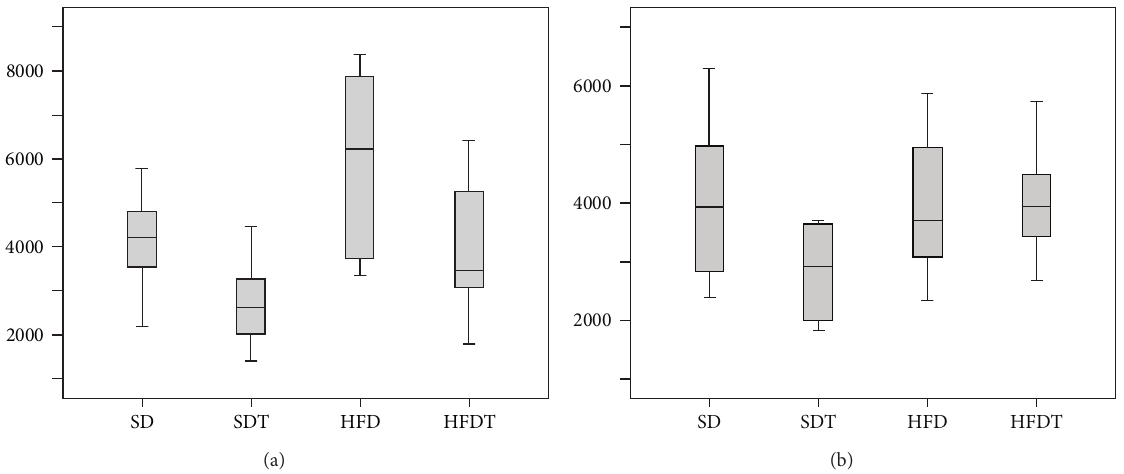
Figure 5: Semiquantitative analysis of the interaction between PTPIP51 and its interaction with IR and with PKA. Every section was subdivided into rectangles of the same size and dots were counted. The results were averaged for each section. (a) Semiquantitative evaluation of PTPIP51 interaction with IR. (b) Semiquantitative evaluation of PTPIP51 interaction with PKA. SD: standard diet group. SDT: standard diet and training group. HFD: high-fat-diet group. HFDT: high-fat-diet and training